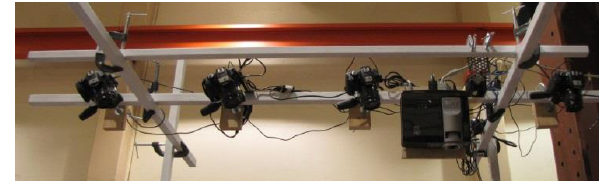
Figure 2. An example showing half the cameras and one of the projectors suspended from the support frame